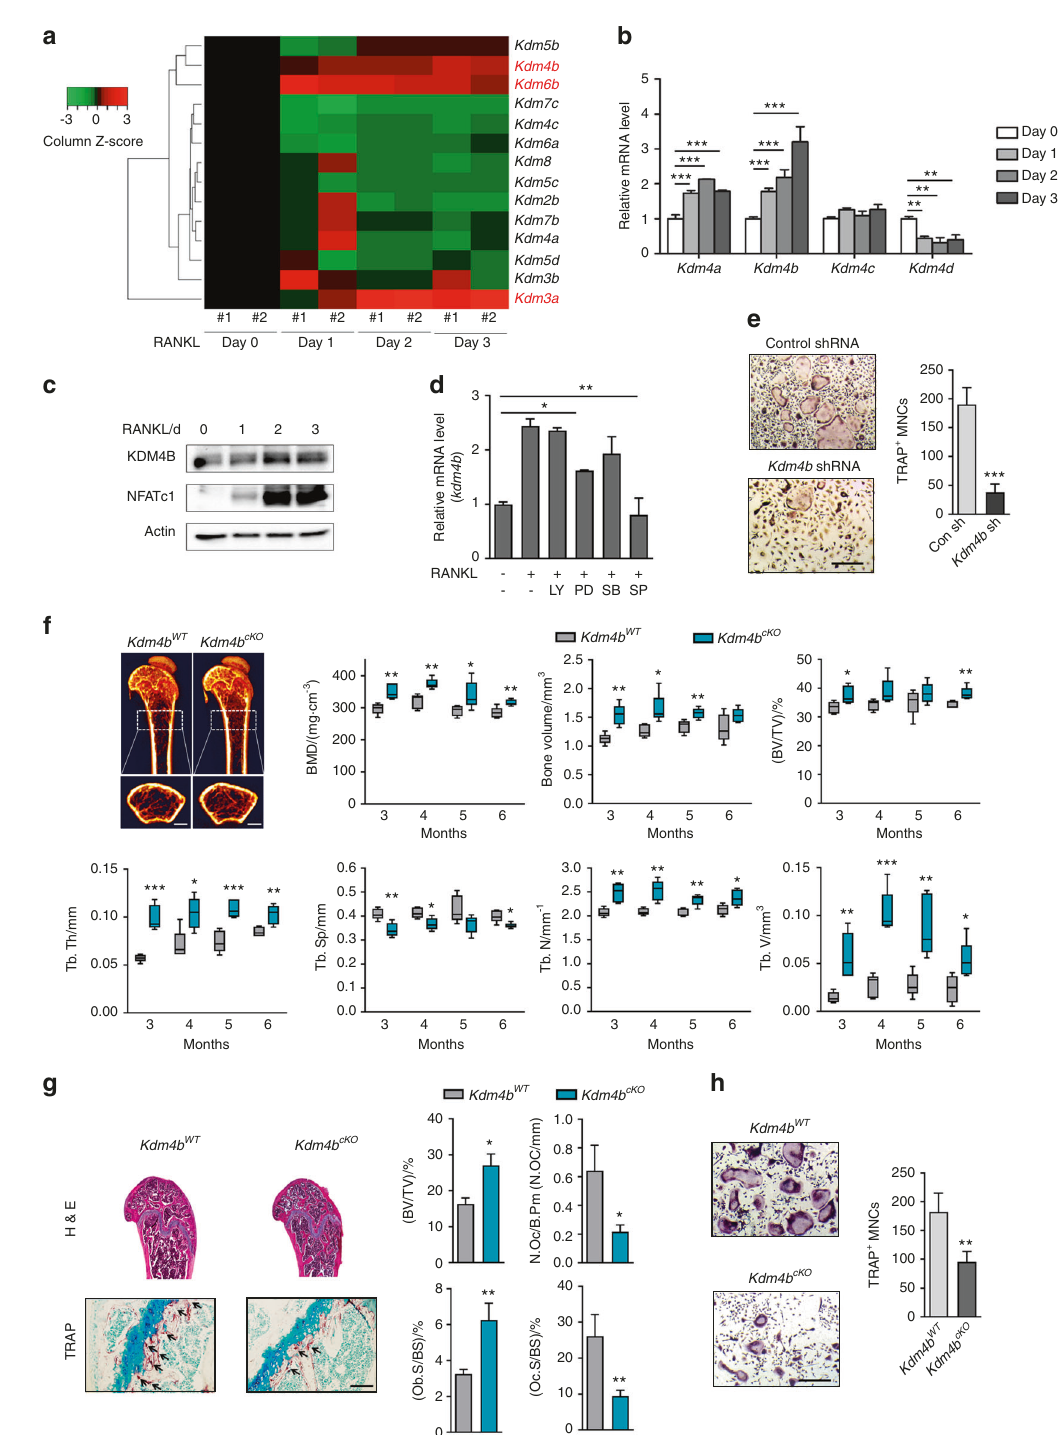
Fig. 1 Myeloid-speci fi c loss of KDM4B increases bone mass and reduces osteoclast activity in vivo. a Heatmap showing mRNA expression pro fi les of histone demethylases during osteoclastogenesis. b Relative mRNA levels of Kdm4a – Kdm4d during osteoclast differentiation. The mRNA levels of each reaction were normalized to the mRNA level of the β – actin control. c Immunoblot analysis of KDM4B expression levels during osteoclastogenesis. d Effects of protein kinase inhibitors on the mRNA expression of Kdm4b (LY, LY294002; PD, PD98059; SB, SB203580; SP, SP600125). e TRAP staining of BMMs expressing either control shRNA or Kdm4b shRNA. Scale bar, 75 μ m. f Micro-CT analysis of the femurs of 3-month-old male Kdm4b WT and Kdm4b cKO mice ( n = 5). Representative micro-CT image of the proximal femur (top, longitudinal view; bottom, axial view). The boxes enclose the 25th to 75th percentile values. The whiskers extend to the maximum and minimum values. The central horizontal bar indicates the median. Scale bars, 1mm. g Histological analysis of femur sections from 3-month-old male Kdm4b WT and Kdm4b cKO mice ( n = 3). The sections were stained for H&E and TRAP. The arrows indicate osteoclasts. Scale bar, 100 μ m. h TRAP staining of BMMs from Kdm4b WT and Kdm4b cKO mice. Scale bar, 75 μ m. The data are presented as the mean±SD values of three independent experiments [two-way ANOVA in ( b ), one-way ANOVA in ( d ), two-tailed t -test in ( e , h )]. In ( f , g ), the data are presented as the mean±SEM values. * P <0.05; ** P <0.01; *** P <0.001. See also Supplementary Fig.